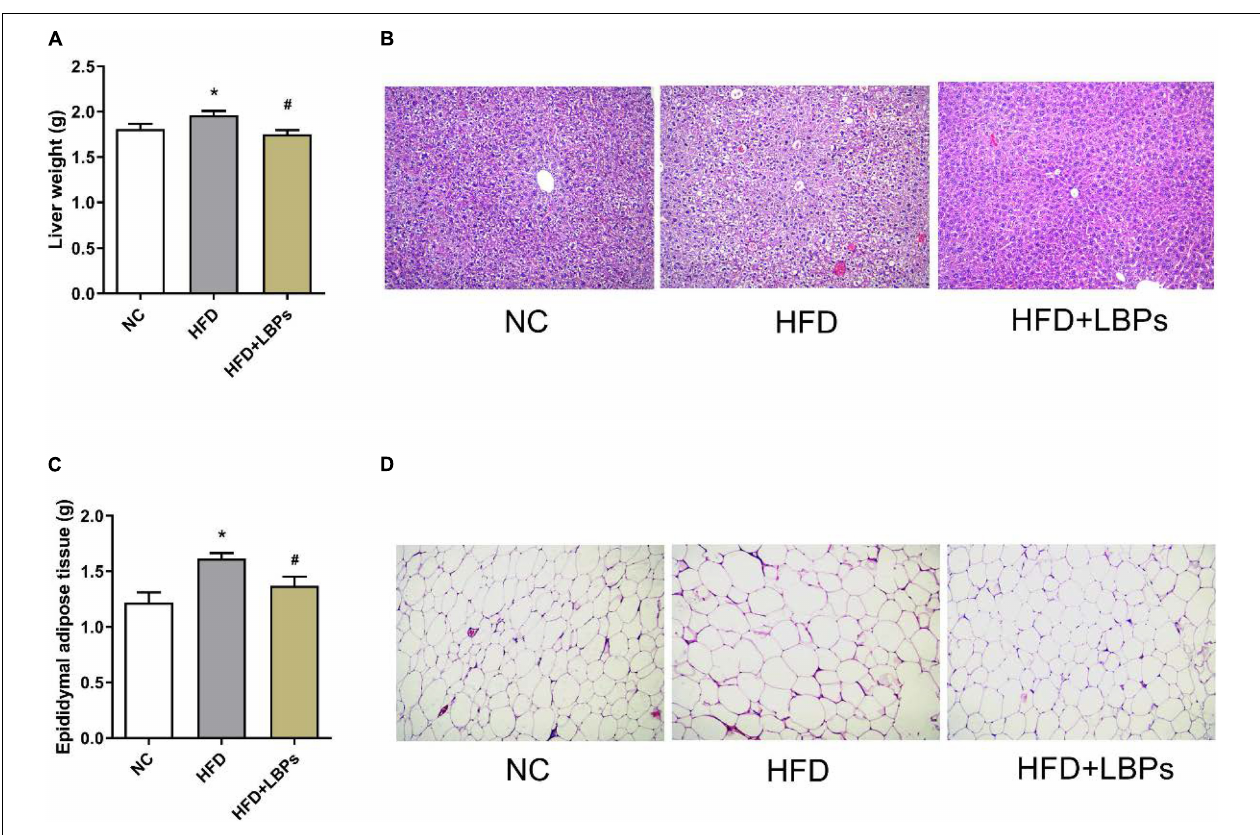
FIGURE 3 | Effects of LBPs on fat accumulation in liver and adipose tissues in HFD-fed mice. (A) Liver weight, (B) histology analysis of liver, (C) epididymal adipose tissues weight, and (D) histology analysis of epididymal adipose tissue. * P < 0.05 vs. NC group and # P < 0.05 vs. HFD